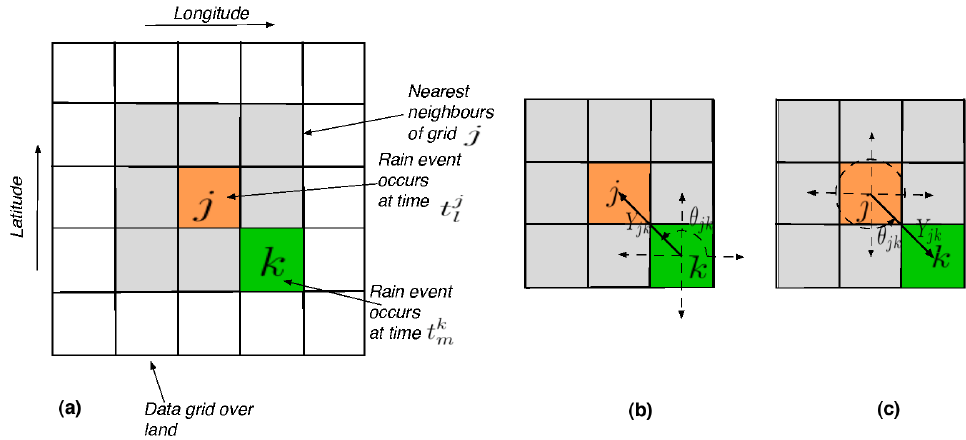
Table 1. Summary of results of Cluster analysis. Data Used Threshold α I l Figure Total Clusters containing percentile no. Clusters greater than 3 grid points APHRO-V0902 94% 1.547 6a 67 38 APHRO-V0902 90% 1.547 6b 45 27 IMD-D 94% 1.538 6c 14 10 IMD-D 90% 1.538 6d 19